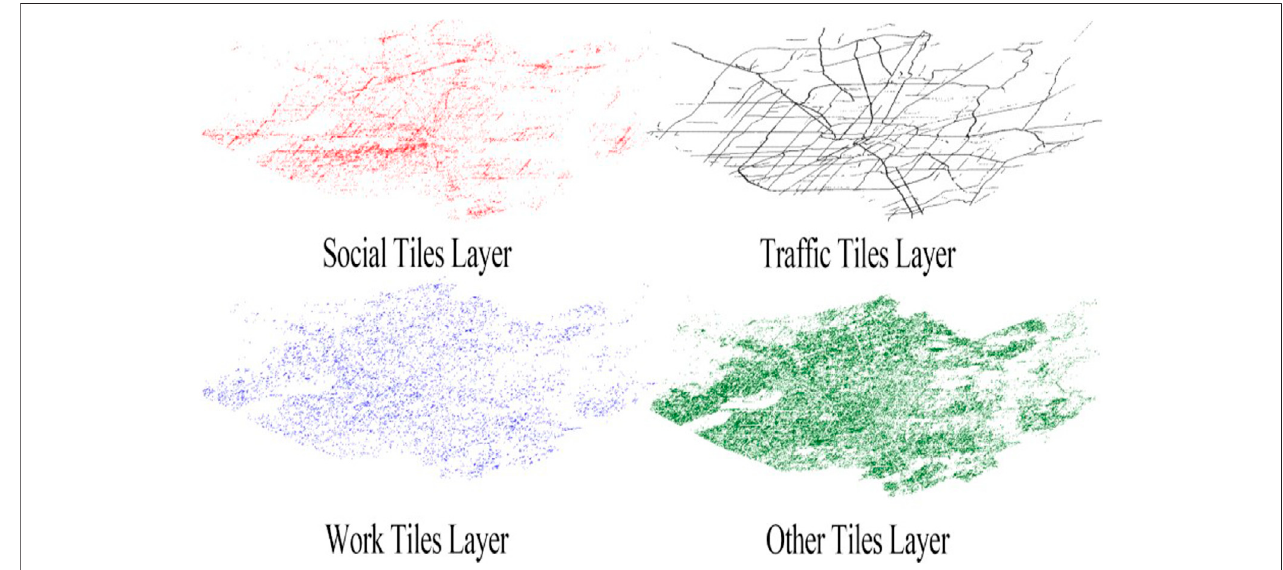
FIGURE 2 | Maps of four different tile categories (social, traf fi c, work, and other) in Harris County, Texas.